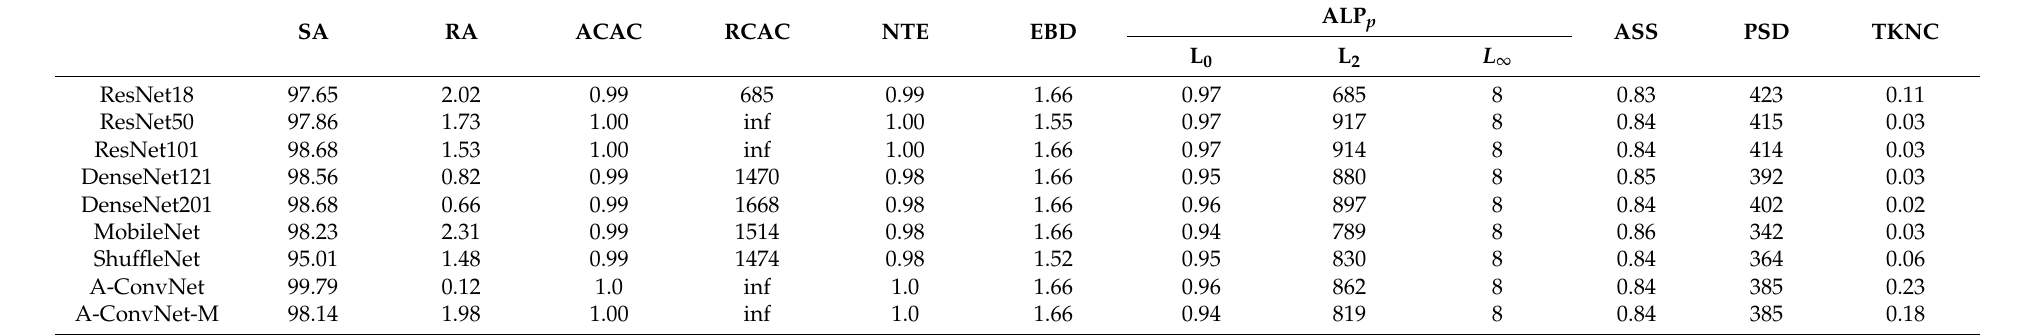
Table 7. Comprehensive evaluation of different DNN models against PGD attack (attack strength is 8/255 in L ∞ norm) in MSTAR dataset.